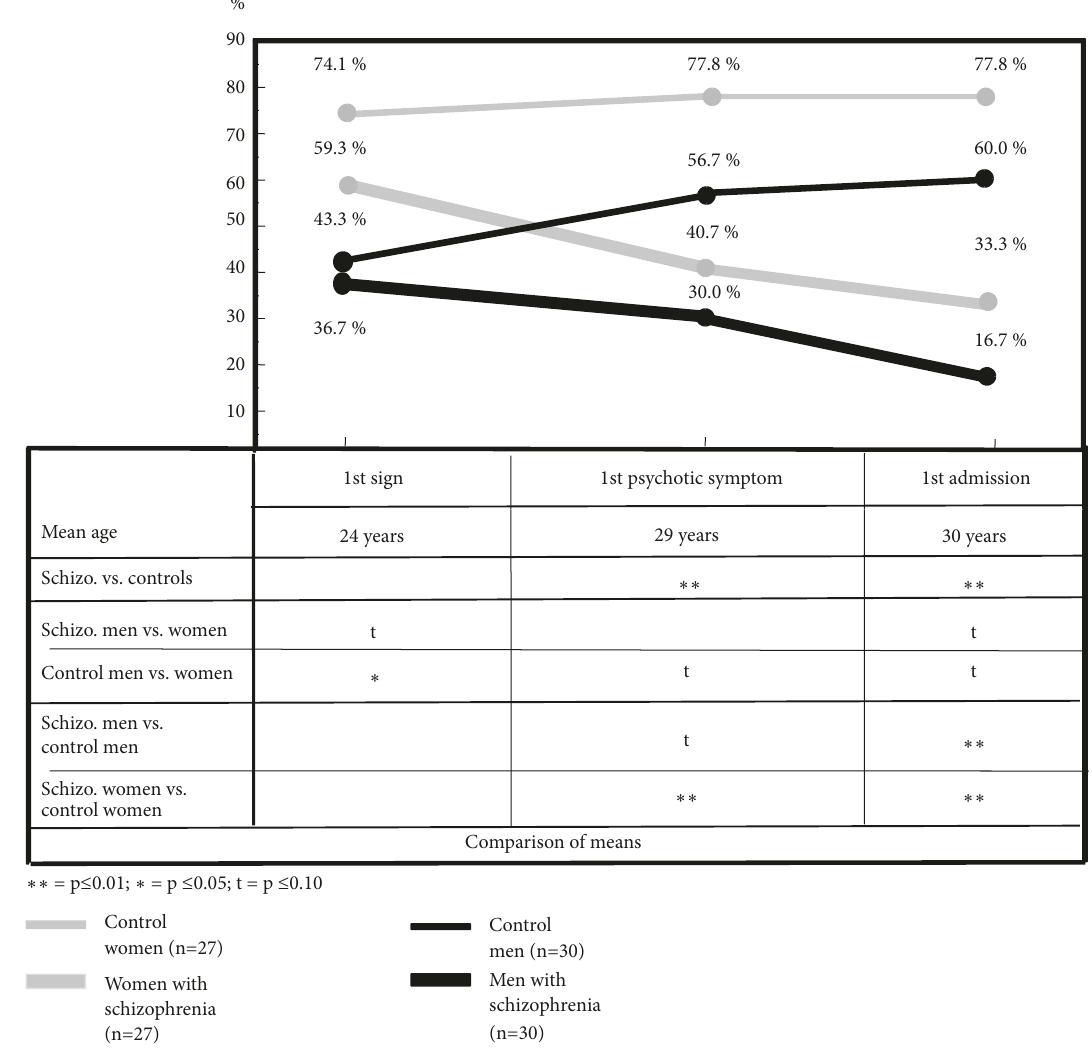
Mean age Schizo. vs. controls Schizo. men vs. women Control men vs. women Schizo. men vs. control men Schizo. women vs. control women